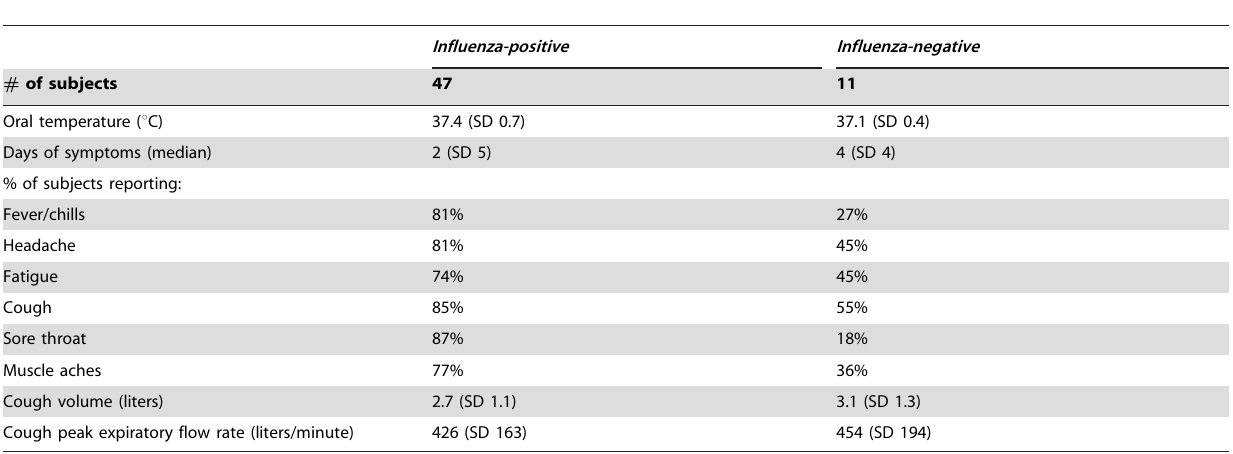
Table 3. Clinical presentation of study